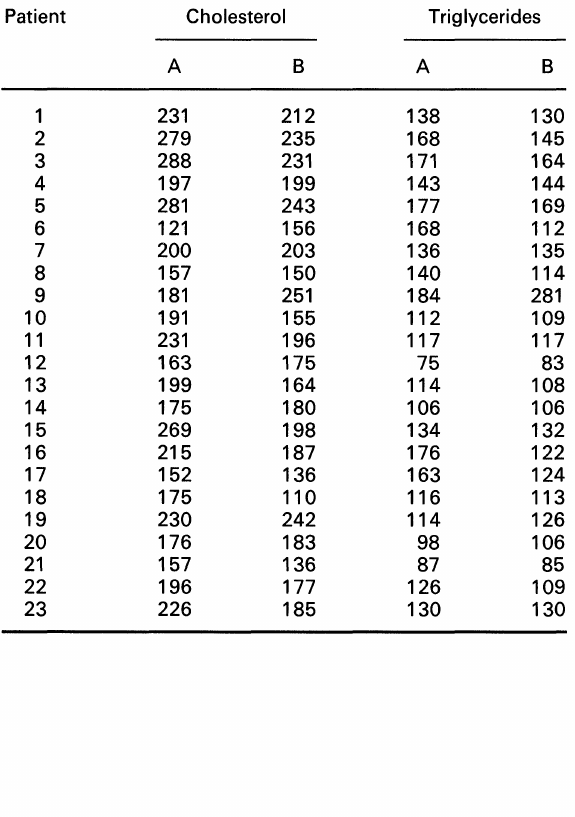
Table 3. Delayed hypersensitivity skin test and mixed lymphocyte reactions (MLR) before (A) and after